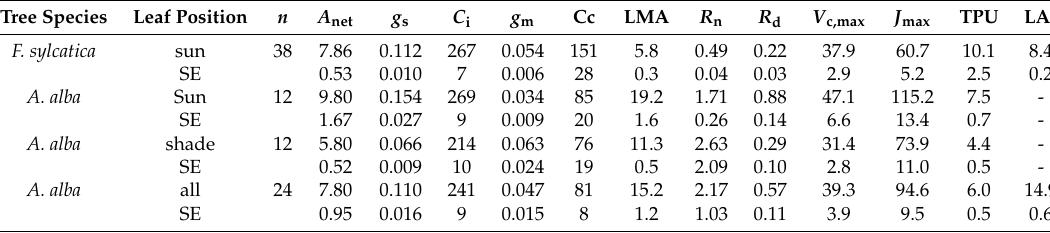
Table 3. Key ecophysiological parameters for beech and fir from the Freiamt experimental site, including photosynthetic variables from gas exchange analyses, leaf morphology and leaf area